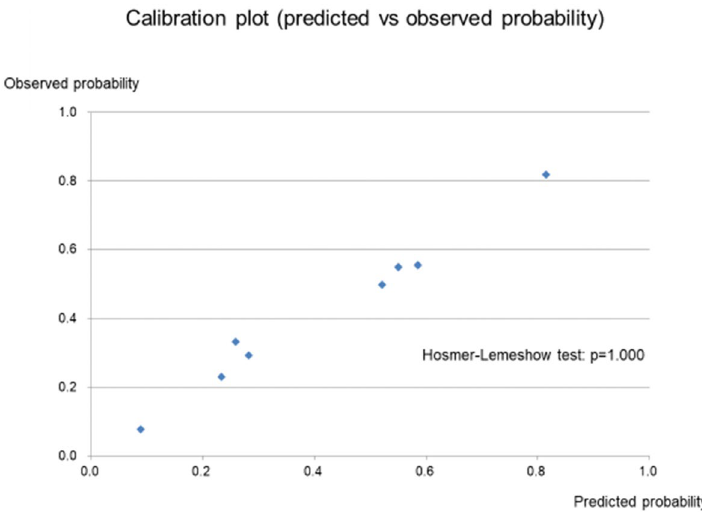
Figure 3. Calibration plot between the probability predicted by PCR score and observed probability. The Hosmer–Lemeshow test confirmed that the observed and predicted probabilities were in excellent